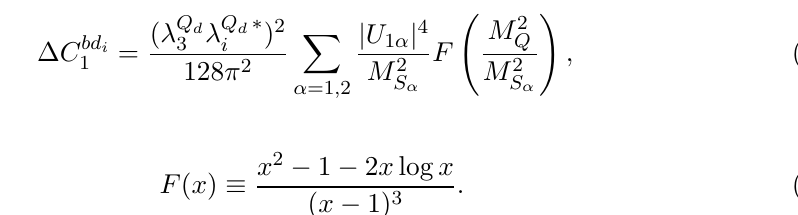
Figure 3 . Illustrative example on the to [30] (red) and the one allowed by B s - B s mixing bound, eq. (3.10) (yellow). Contours show (cid:0)( B ! K ( (cid:3) ) (cid:23) (cid:22) (cid:23) ) normalised by the SM value. The model’s parameters were set to: M S = 350 GeV, M D = 500 GeV, a H = 20 GeV, M L = 800 GeV, M Q = 1 : 5 TeV, (cid:21) L couplings were set to